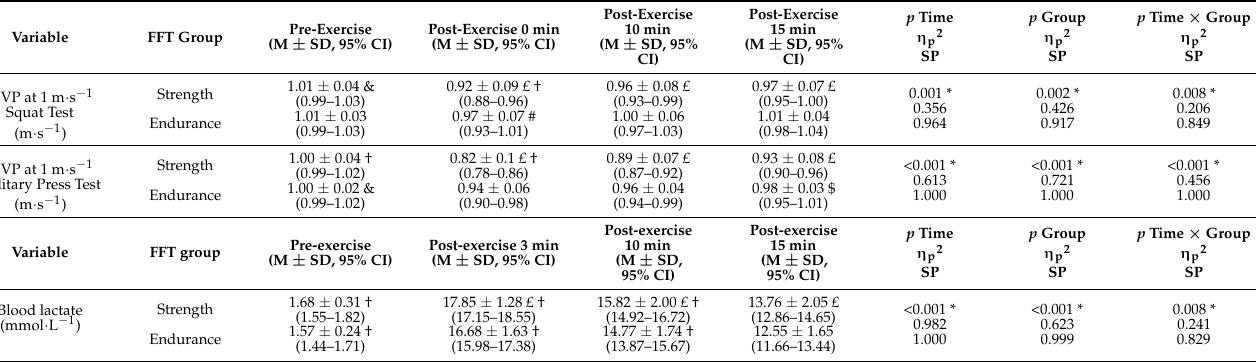
Table 2. Analysis of the variable velocity and blood lactate before and after performing the strength and endurance FFT protocols.